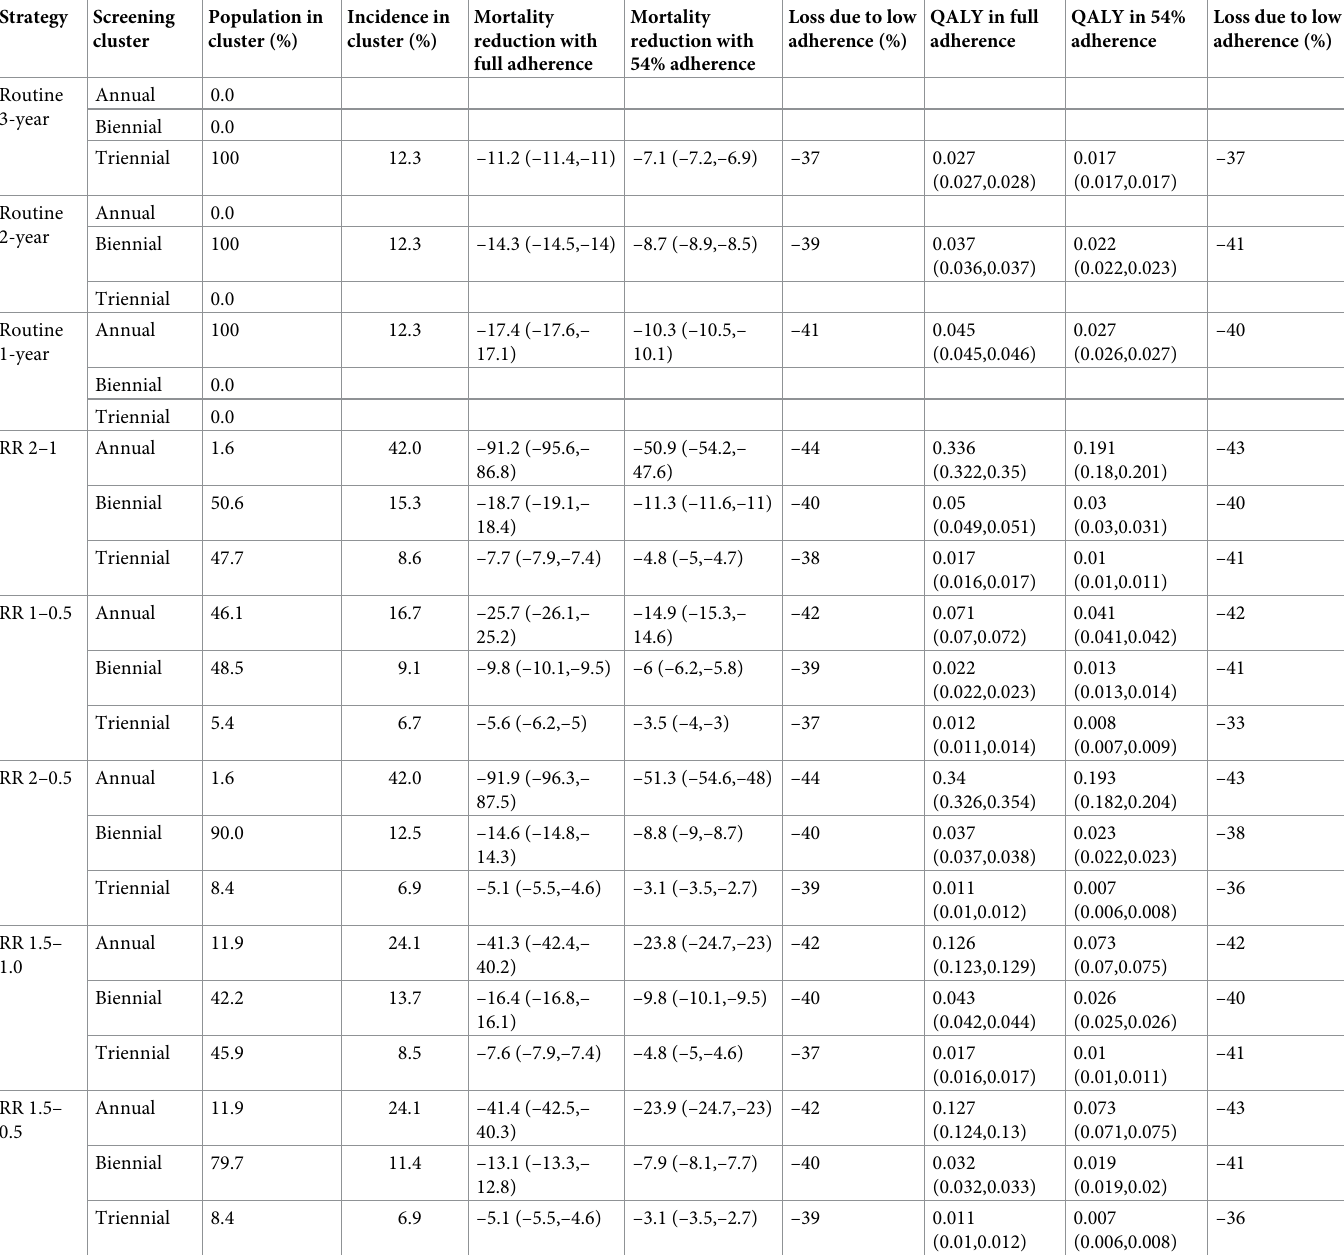
Table 3. Subgroup analysis, performance in